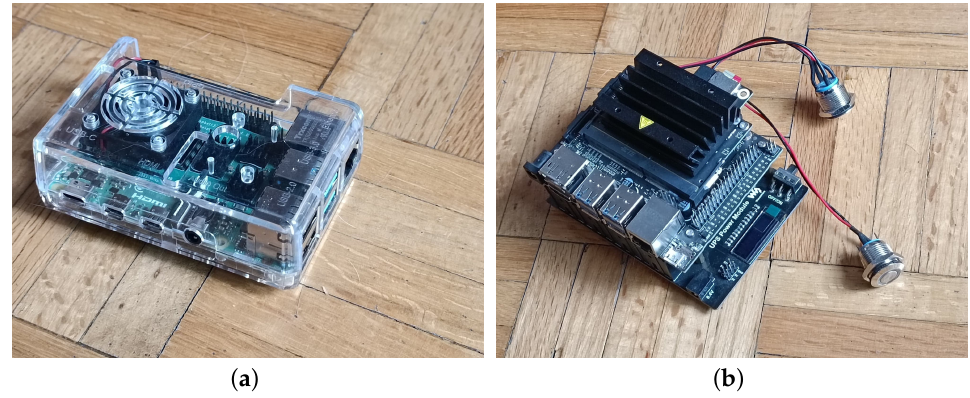
Figure 5. Embedded systems using in this research: ( a ) Raspberry Pi 4 board; and ( b ) Jetson Nano